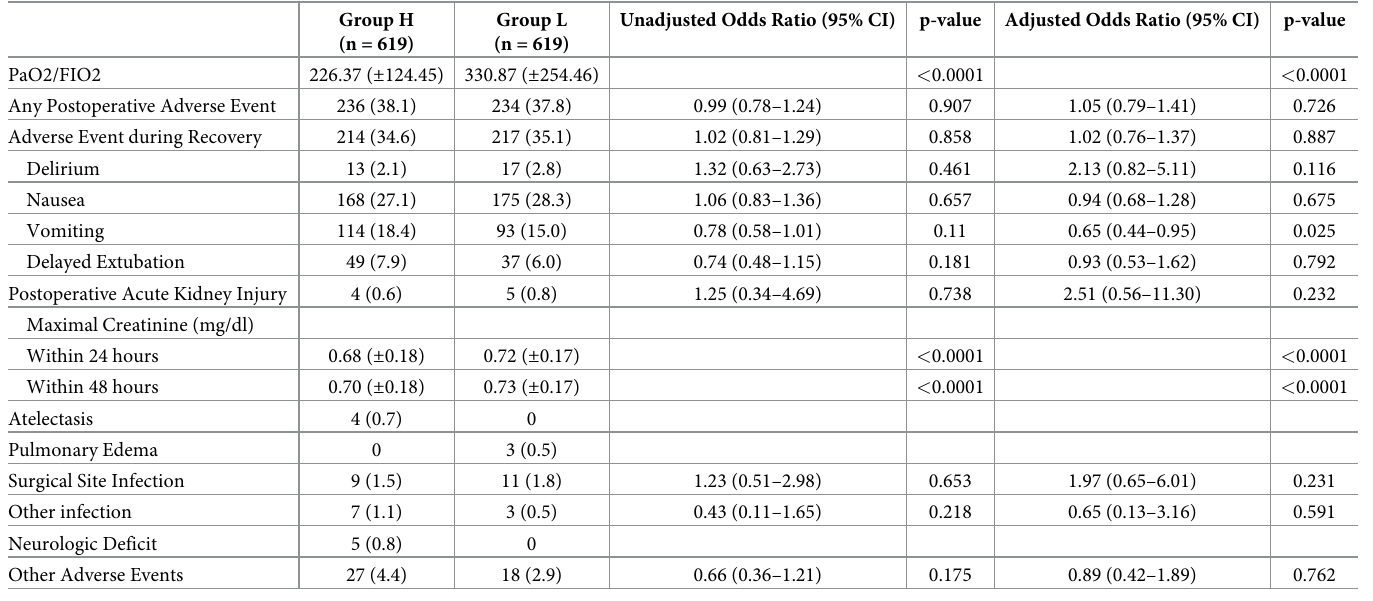
Table 4. Clinical outcomes in the propensity-matched